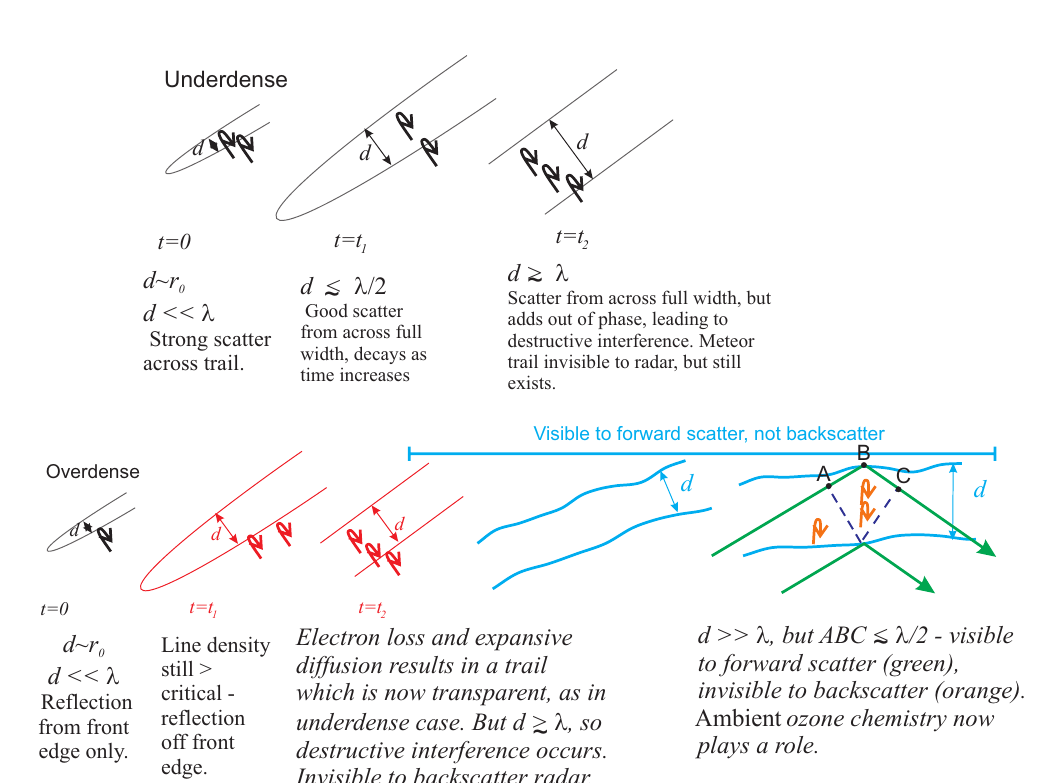
Figure A1. Demonstration of the different geometries associated with backscatter and forward-scatter observation of meteor trails. Note how forward-scatter systems can see the trails to much greater widths than the backscatter case. The upper three panels refer only to underdense backscatter. The lower line of panels shows backscatter behaviour on the left (first three panels), showing the transition to underdense behaviour as time evolves. The two panels on the right show how the tail may twist to become quasi-horizontal, and how the oblique forward scatter allows the tail to be visible to much greater widths than is possible with backscatter. Note that the transition scales indicated ( λ /2, λ etc.) are approximate. More exact values can be seen in Appendix C. For example, Poulter and Baggaley (1977) suggest that the amplitude of an underdense meteor falls to half its peak when the 1/ e density trail radius is a = 0.195 λ , so we might consider a meteor signal as disappearing when the radius is about twice this (since the amplitude is now 1/4 of the peak, and the power is 1/16 of peak power). In this case the 1/ e density diameter is 0.78 λ , but the meaning of “disappear” depends on noise levels and initial amplitudes, so this can only be considered as a representative example. The diagrams used here are meant to be applied in a more subjective